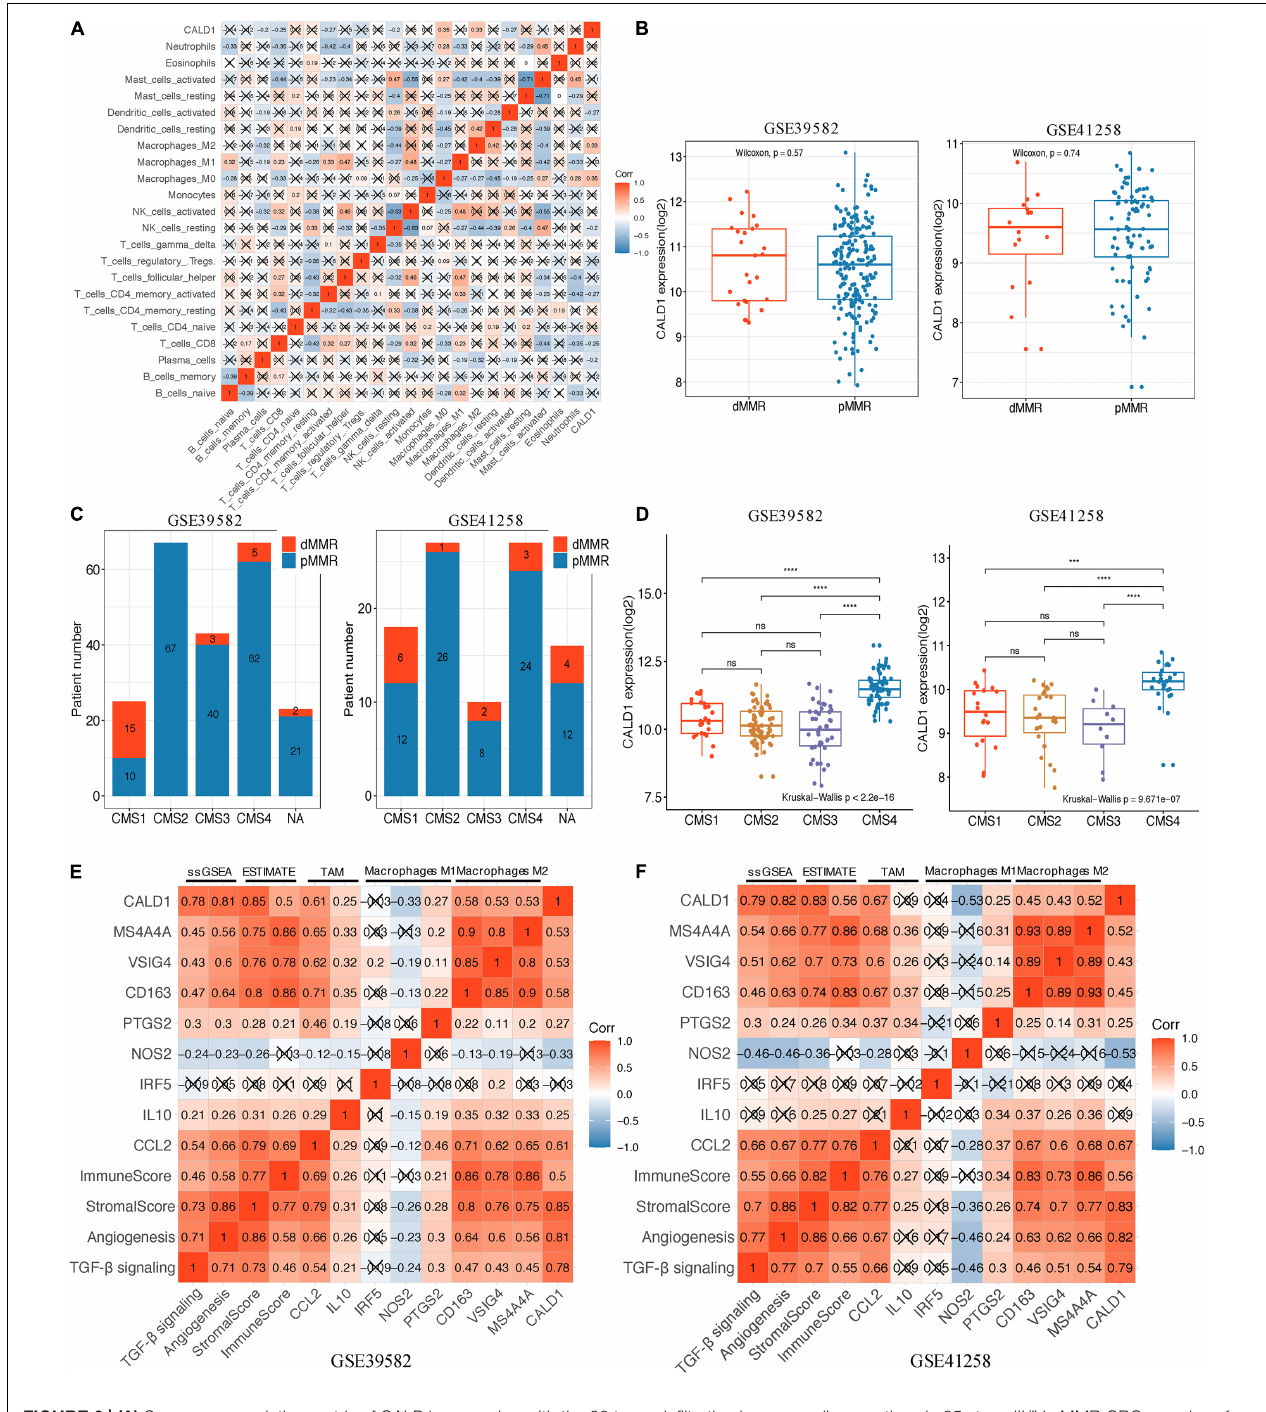
FIGURE 6 | (A) Spearman correlation matrix of CALD1 expression with the 22 tumor-infiltrating immune cell proportions in 85 stage III/IV pMMR CRC samples of GSE39582. (B) Boxplots of CALD1 expression between dMMR and pMMR stage III/IV CRC samples in both GSE39582 (left) and GSE41258 (right) datasets. (C) Histograms of the distribution characteristics of stage III/IV dMMR and pMMR CRC patients in each CMS subgroup. NA, not assigned. (D) Boxplots exhibiting CALD1 expression was significantly and specifically upregulated in the CMS4 subtype in both GSE39582 (left) and GSE41258 (right) datasets. Significant differences between CMS subgroups were indicated as follows: ns, not significant; *** P < 0.001, **** P < 0.0001 (Kruskal–Wallis test followed by Dunn’s tests). (E,F) Correlation heatmap revealed that CALD1 expression was significantly and positively correlated with angiogenesis and TGF- β signaling ssGSEA enrichment scores, immune and stromal scores, gene markers of TAMs (CCL2 and IL10), and M2 macrophages (CD163, VSIG4, and MS4A4A) but was not clear with gene markers of macrophage M1 (IRF5, NOS2, and PTGS2) in the GSE39582 (E) and GSE41258 (F) datasets. pMMR, mismatch-repair-proficient; dMMR, mismatch-repair-deficient; CRC, colorectal cancer; CMS, consensus molecular subtypes; TAMs, tumor-associated